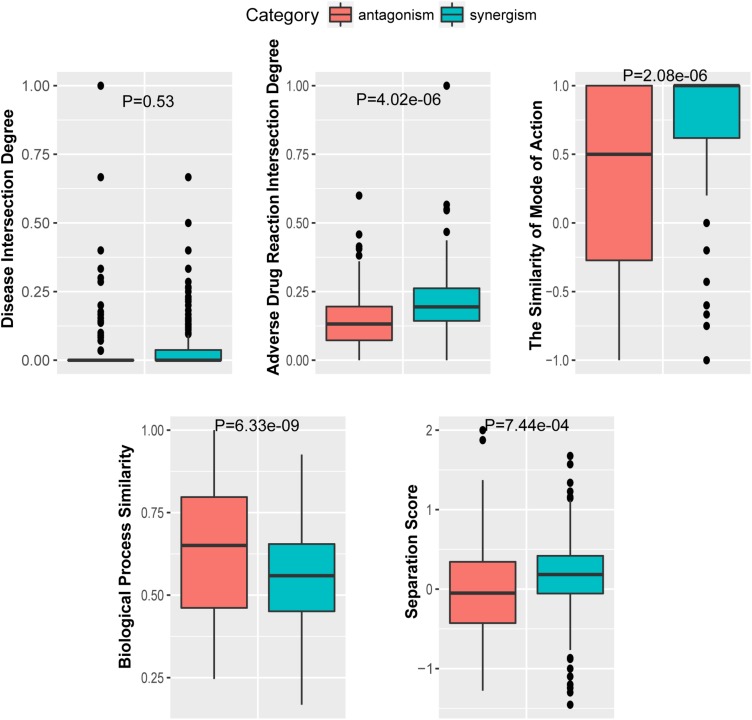
The t-test for the five optimized features.